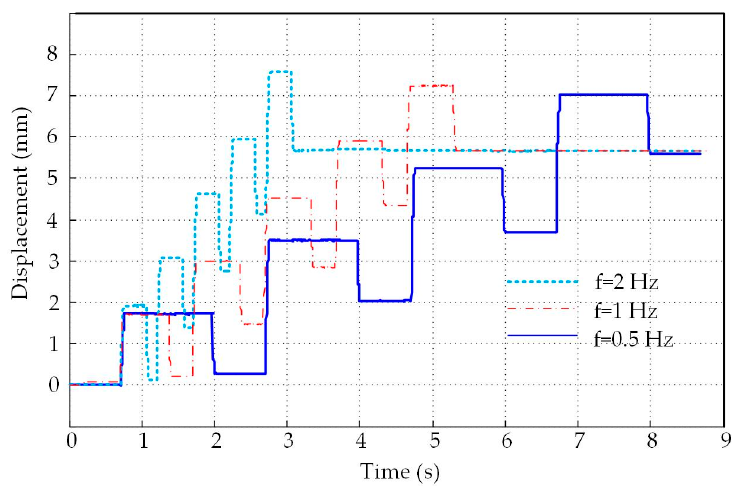
Figure 14. CR displacement vs. current frequency.